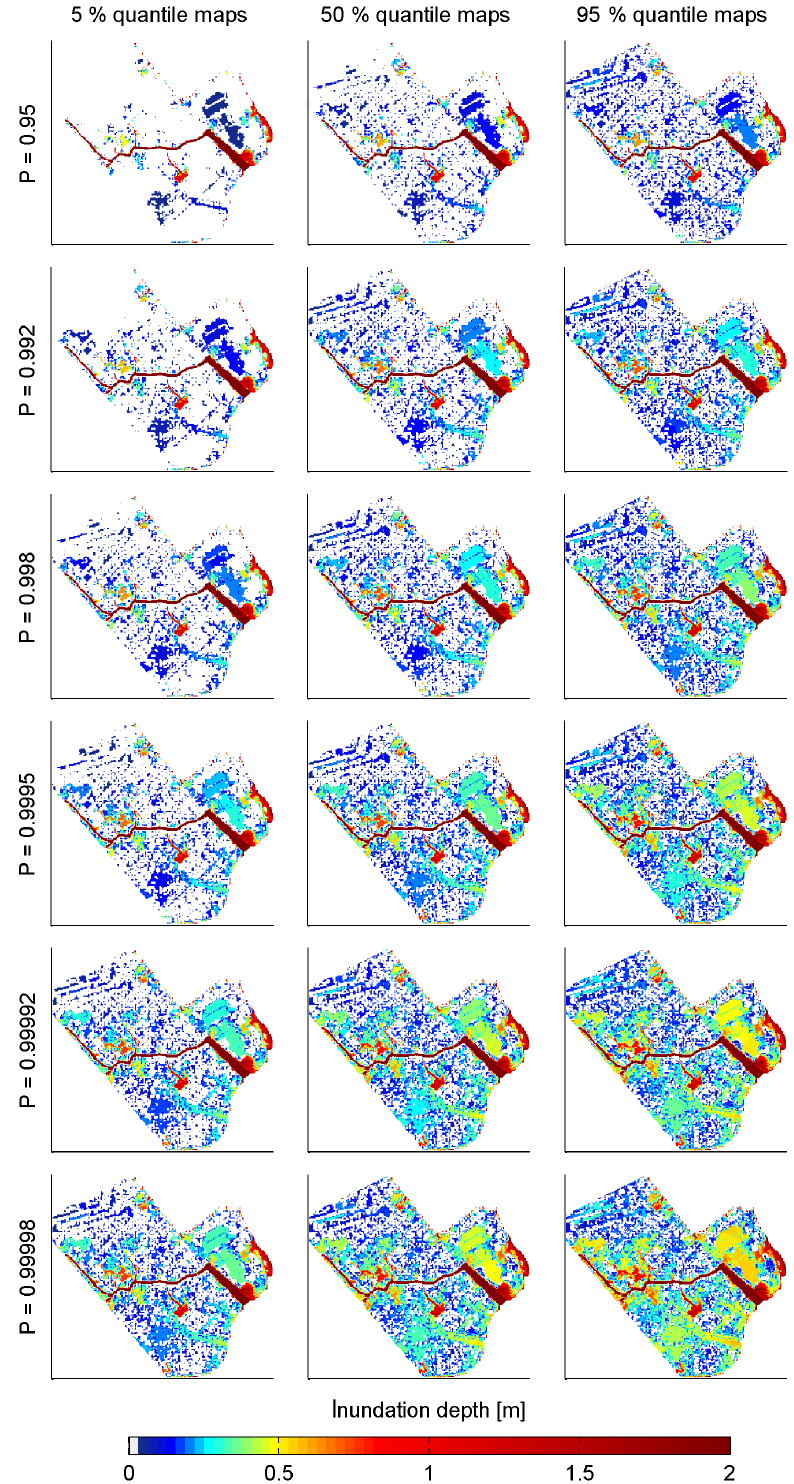
Figure 14. Probabilistic combined fluvial–pluvial flood hazard maps for Can Tho showing maximum inundation depths: for the derived p levels (annual probabilities of non-exceedance), the median (50% quantile) maps and associated 5 and 95% quantile maps are shown illustrating the uncertainty of the hazard estimation. Note that the p levels are different to the fluvial and pluvial hazard maps due to the discrete combinations of fluvial and pluvial p levels. Maximum inundation depths < 0.02m are indicated as no inundation.